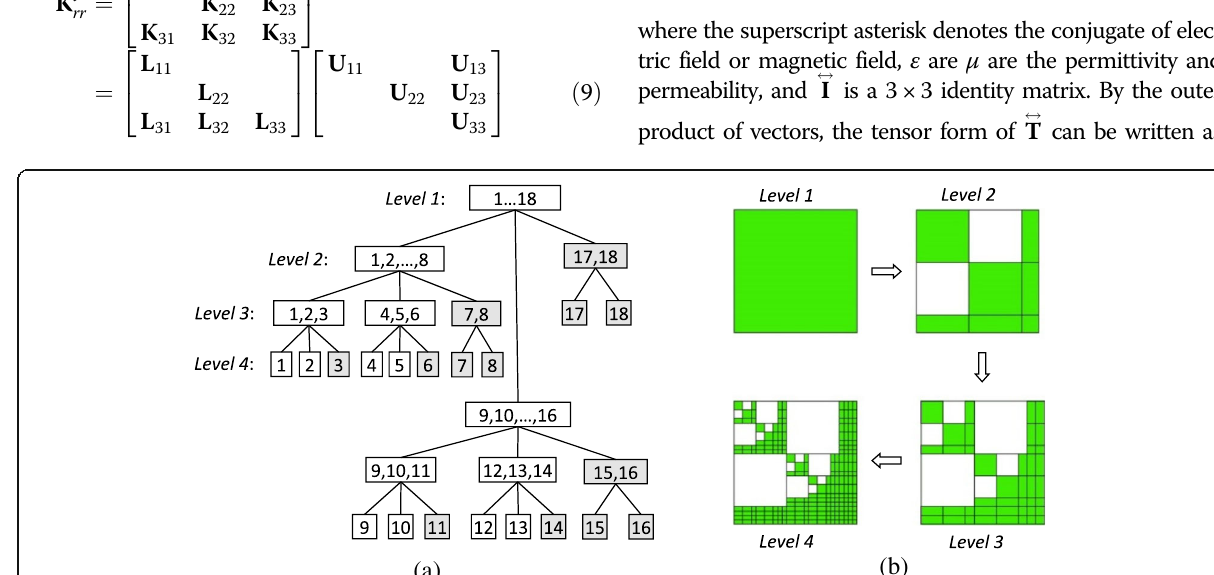
Fig. 2 Constructions of a cluster tree and a block cluster tree of 4 levels based on nested dissection. a Construction of a cluster tree by recursive subdivision of edge-based basis function set I = {1,2, … 18}. b Construction of a block cluster tree where white blocks are zero matrices and green blocks can be full matrices or low-rank decomposition